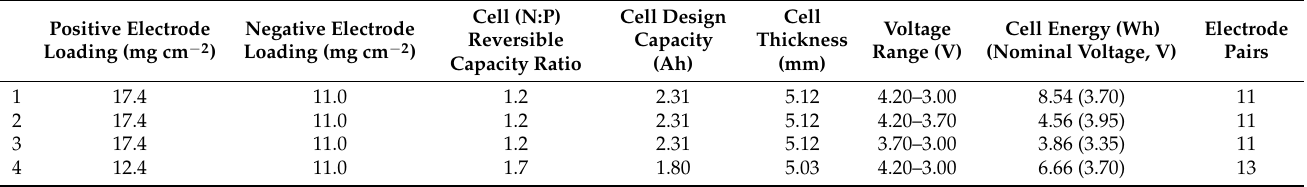
Table 1. Summary of cell designs used for fast charging evaluation. Cell thickness and electrode pair numbers were targeting a cell with a thickness of ~5 mm. Capacities based on 150 mAh g − 1 NMC. Positive Electrode Loading (mg cm − 2 )